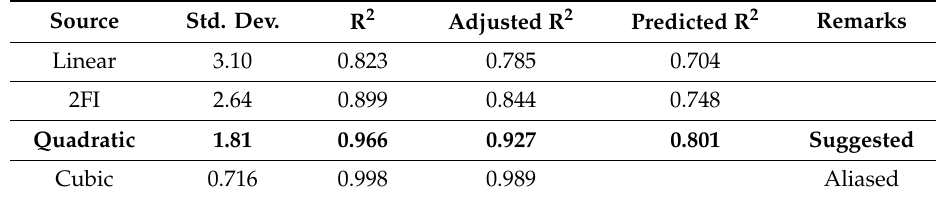
Table 7. ANOVA for the quadratic model.